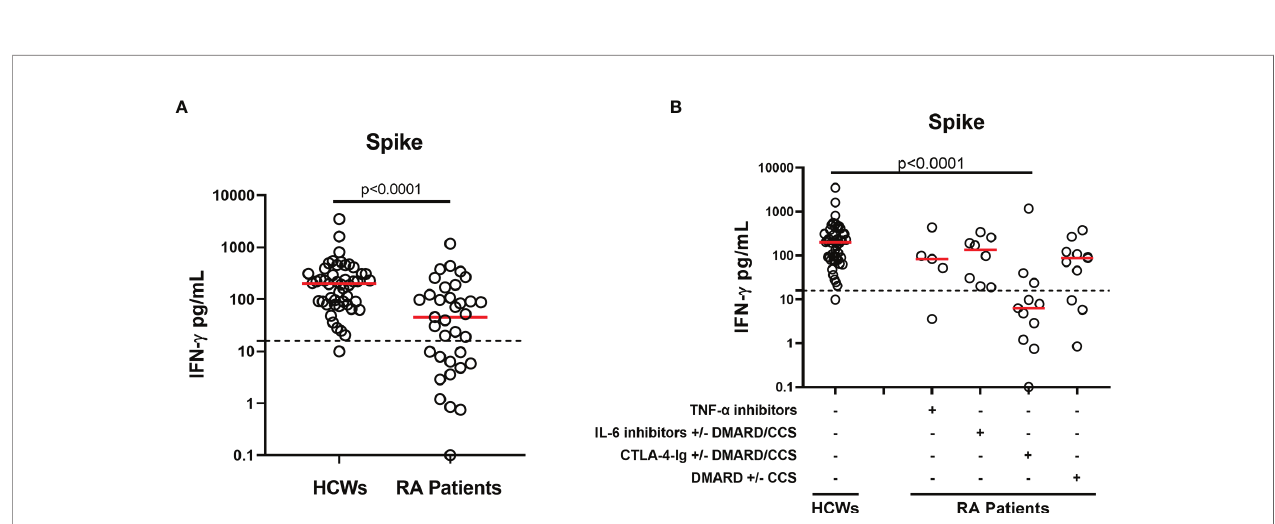
FIGURE 6 | T-cell response after SARS-CoV-2 vaccination in HCWs and RA patients. (A) Evaluation of IFN- g -spike-speci fi c T-cell response 6 months after vaccination in the total of HCWs (n = 49) and RA patients (n = 35). (B) RA patients were strati fi ed based on drug treatment in four groups: TNF- a inhibitors (n = 5), IL-6 inhibitors with or without DMARD/CCS (n = 8), CTLA-4-Ig with or without DMARD/CCS (n = 11), and DMARD with or without CCS (n = 11). T-cell response to spike antigen was assessed by measuring IFN- g levels in plasma harvested from stimulated whole-blood samples. The reported IFN- g values were subtracted from the background. Dashed lines identify the cutoff of the test (spike: 16 pg/ml). The red horizontal lines indicate the median. Statistical analyses were performed using Mann – Whitney U-test with Bonferroni correction (p ≤ 0.0125). SARS-CoV-2, severe acute respiratory syndrome coronavirus 2; CCS, corticosteroid; DMARDs, disease-modifying antirheumatic drugs; RA, rheumatoid arthritis; HCWs, health care